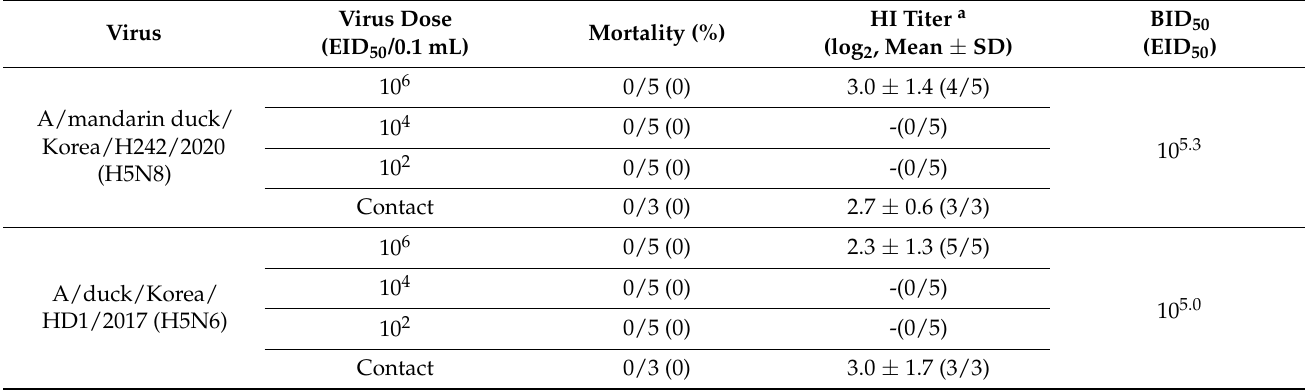
Table 2. Pathogenicity and transmissibility of H242/20(H5N8) and HD1/17(H5N6) in ducks.